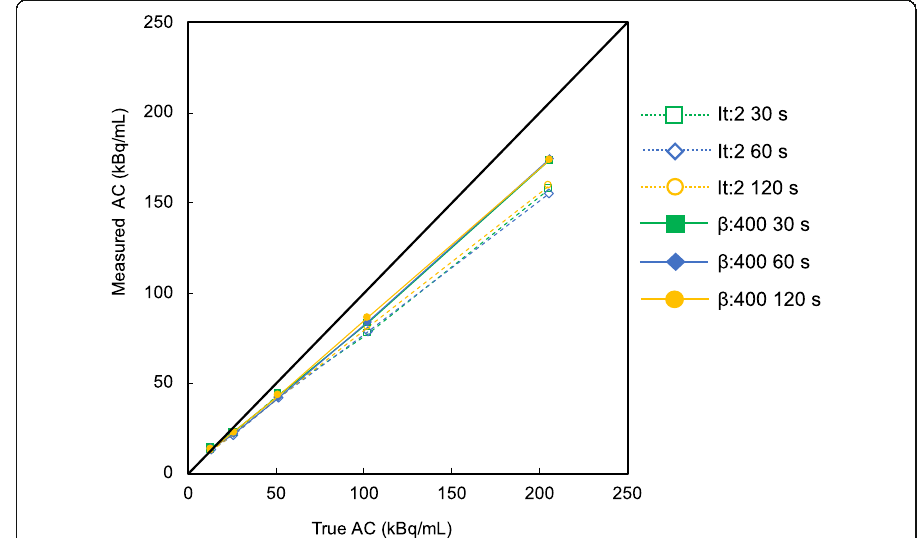
Fig. 6 Correlation between true and measured activity concentrations. The RC linearity over a range of activity was measured using five spheres with diameters of 13 mm containing TNR of 1, 2, 4, 8, and 16 at the normal spine activity concentration of 15.6 kBq/mL. Unfilled symbols and dotted lines, OSEM; filled symbols and solid line, BPL. AC, activity